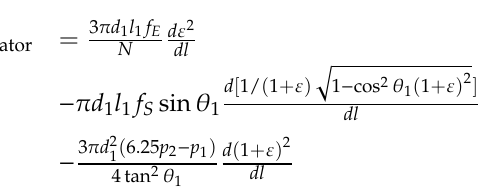
Figure 7. Test the output force of ECFA. ( a ) Calculating the force of the ECFA. ( b ) Buckling of the ECFM when was pressurized. ( c ) calculating the extension force of the ECFA with a 3D-printed rigid bracket. We tested the pressure-displacement characteristics of ECFA. When the extensor and contractor muscles were pressurized separately, displacement in the opposite direction would occur, as shown in Figure 8a. Therefore, we can actively control the actuator’s movement range from − 0.05 to 0.18. The positive displacement caused by the extensor is larger because the resistance of the contractor is smaller and the action area of pressure is larger. From this, it can be seen that the reverse displacement caused by the contractor is smaller. The method of verifying the mathematical model of output force is to first pressurize the extensor muscle with air pressures of 0.1 MPa, 0.2 MPa, 0.3 MPa, and collect the output force corresponding to the air pressure by the load cell. Next, we start to continuously pressurize the contractor muscle, and the contractor will produce contraction force. This contraction force will gradually reduce the output force of the extensor. The elongation rate of the actuator can be controlled by adjusting the z -axis stepper motor of the three-degree-of-freedom platform, even under pressurized state. The test results and simulation results when elongation rate is zero are shown in Figure 8b. We find that the relationship between the input pressure and output force is nonlinear and hysteretic. The repeatability is also not so excellent. In fact, it reveals some general challenges that soft actuator are faced with, that is, high nonlinearity, serious hysteresis, and poor repeatability, which mainly influence the accuracy. We think the nonlinearity is mainly determined by nonlinear mechanics of the soft materials, such as hyperelasticity of the silica gel bladder and fabric layers. When the pressure of the extensor muscle is 0.1 MPa, the required pressure of the contractor muscle is 0.3 MPa to balance the output force of the extensor. At this time, the soft actuator output force is zero, and the length is the initial length. After calculation, the average error between the test results and the simulation results is 7.36%. In the modeling process, we considered the friction between the fabric layer and the silicone body, but ignored the friction between the yarns of the fabric layer. Although it is small, it will also have a certain impact on the results. The second is that when